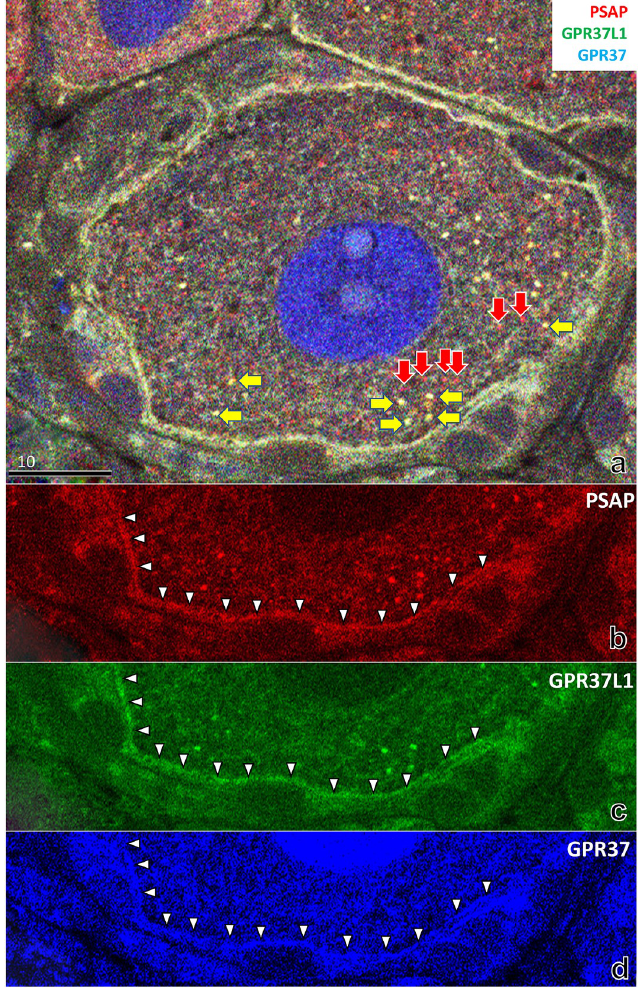
Fig 8. Higher magnification immunofluorescence light micrographs of the rat DRG at 8 weeks show the colocalization of PSAP and its receptors (GPR37, GPR37L1). In the lysosome-like structures in the neuronal cytoplasm, PSAP colocalized with GPR37L1 (yellow arrows), or existed in isolation (red arrows). Note that the lysosome with GPR37L1 is much bigger than the lysosome without GPR37L1(a, b). In the lysosome-like structures, colocalization of PSAP and GPR-37L1 was frequently observed (b, c), while PSAP did not colocalize with GPR-37 (b, d). In satellite cells, fine granular PSAP always colocalized with both GPR-37 and GPR-37L1, and accumulated near the boundary of neurons and satellite cells (arrowheads in